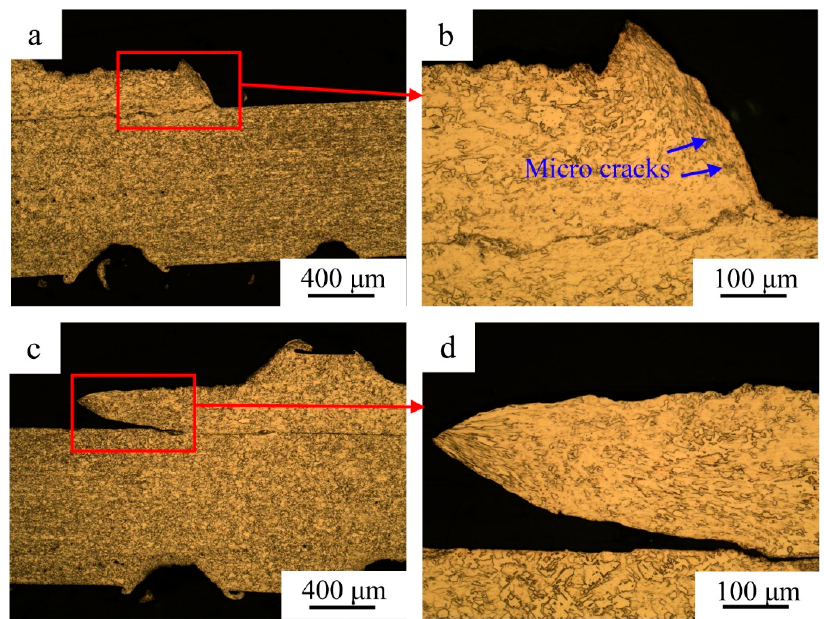
Figure 12. Side views of the optical images of the fracture path for the joints without ( a , b ) and with alcohol ( c , d ) at 0.55 MPa welding pressure.